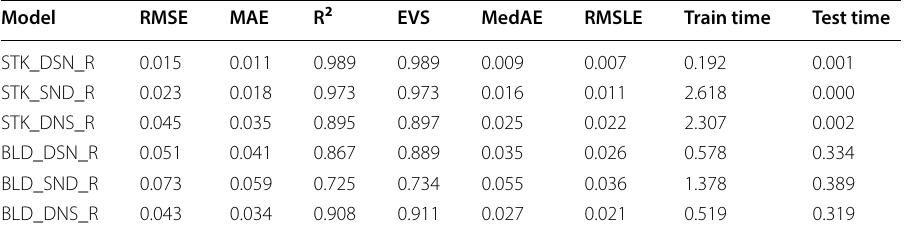
Table 24 Stacking and blending ensemble regressors error metrics result on NYSE dataset Model